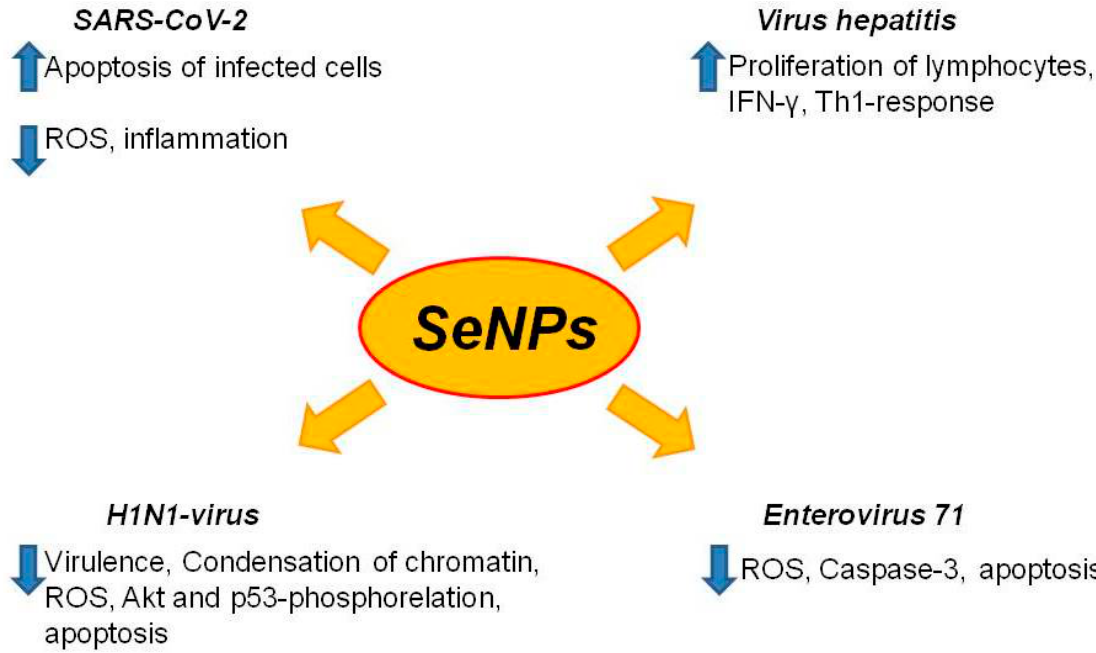
Figure 7. Known effects of selenium nanoparticles on viral infections. SeNPs—selenium nanoparticles; ROS—reactive oxygen species; Akt—Akt/protein kinase B; p53—transformation-related protein 53; IFN- γ —interferon gamma; Th1-response—Th1-type cytokines. Blue arrows pointing up indicate an increase in gene expression, arrows pointing down indicate a decrease in gene expression.